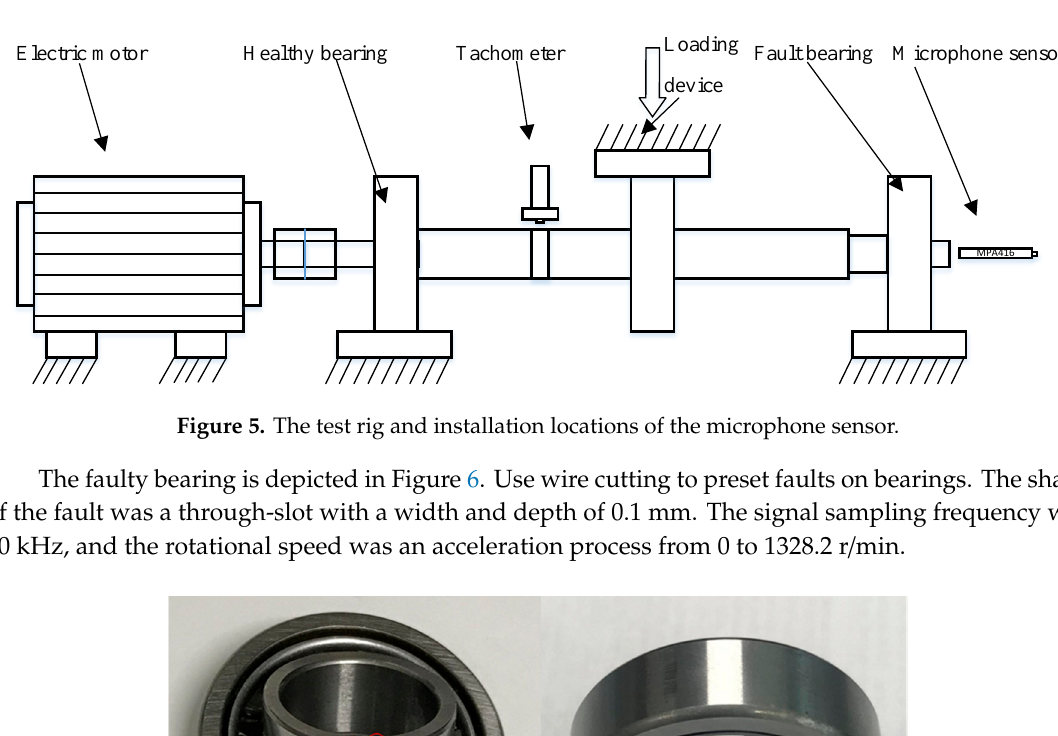
Figure 6. The fault bearing, with defects in (left) inner and our race, (right) rolling element.